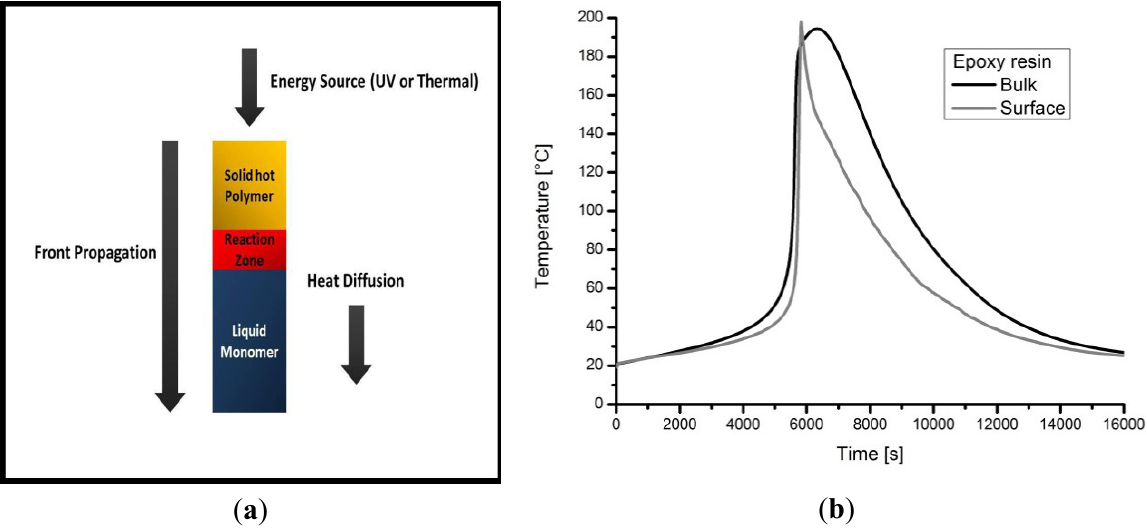
Figure 4. ( a ) Schematic representation of the frontal polymerization reaction; ( b ) temporal temperature profiles from the two thermocouples placed in the bulk and on the surface of the liquid